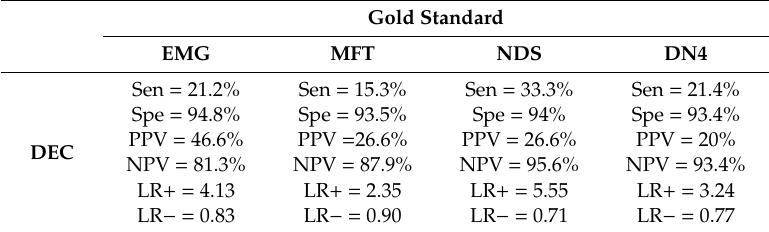
Table 3. Comparison between dermal electrochemical conductance (DEC) results and other tests such as the gold standard based on the glycemic state of the participants. Gold Standard MFT EMG NDS DN4 DM No-DM Pre-DM DM No-DM Pre-DM No-DM Pre-DM DM 95.5% 95.5% 3.57 0 0 0.71 5.28 0.14 4.28